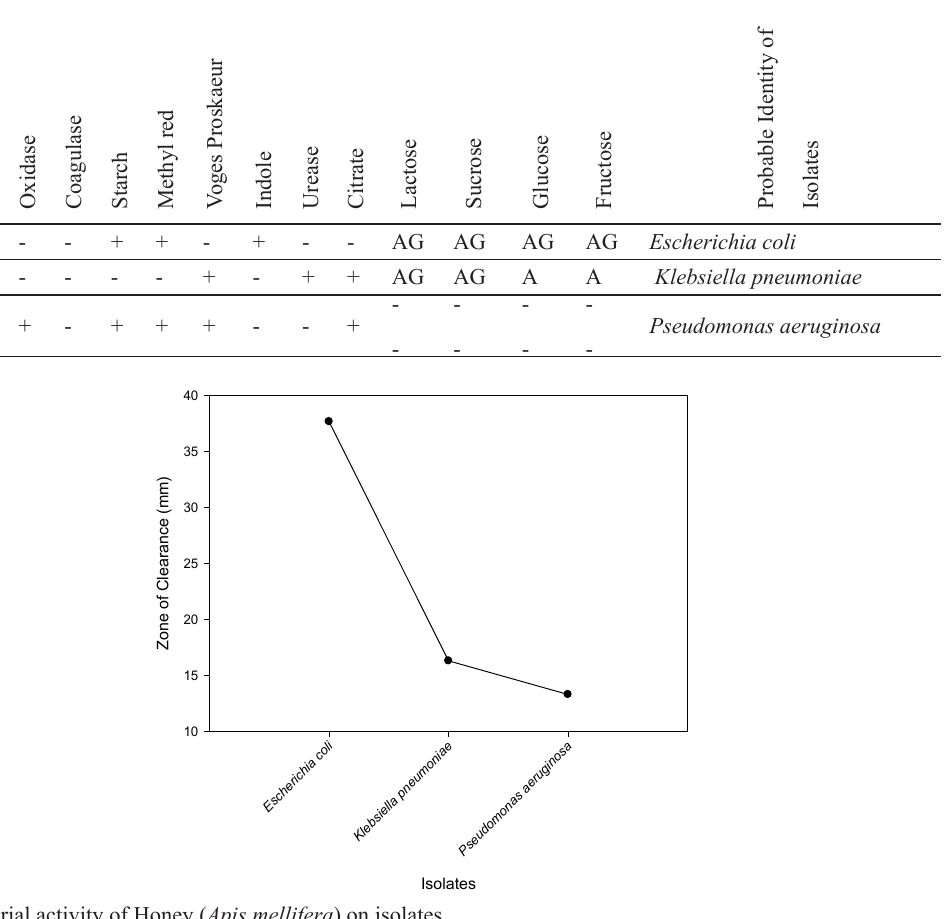
Table 2: Biochemical characterization of bacterial isolates